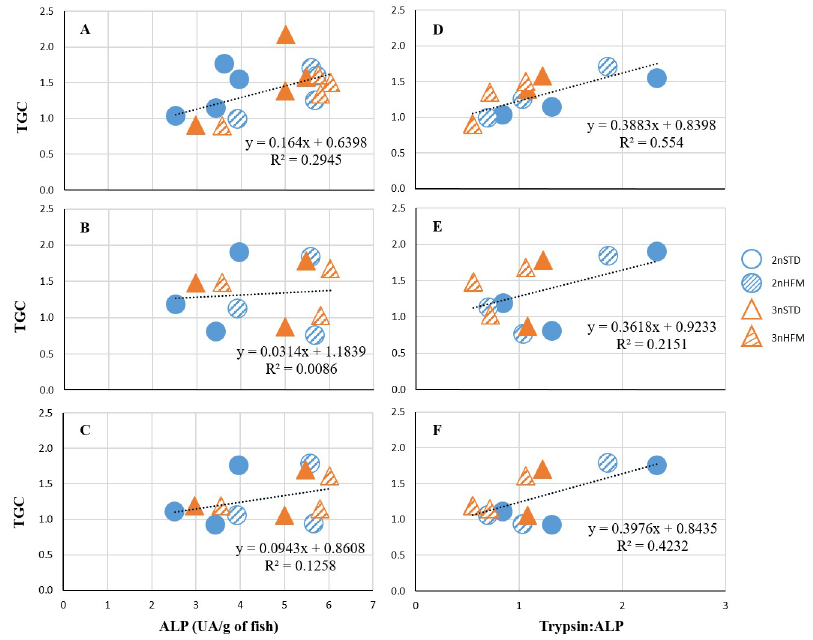
Fig 14. Relationship between TGC and ALP activity or trypsin-to-ALP ratio. TGC data and specific activity of ALP (A-C) activity (expressed as UA/g of fish) and trypsin-to-ALP ratio (D-F) recorded in the intestine of diploid and triploid fish fed fish meal (STD) and hydrolysed fish protein (HFM) diets in the period (A,D) prior to sampling, (B,E) after sampling and (C,F) in whole